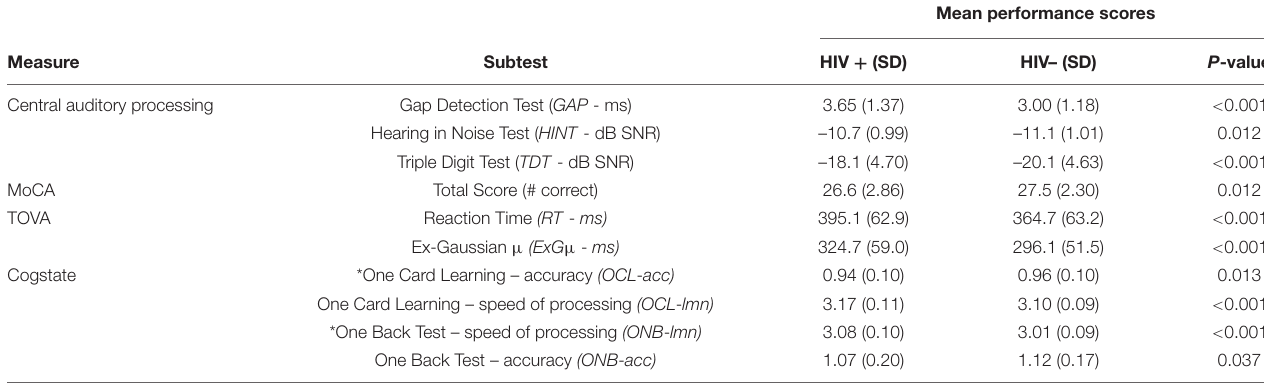
TABLE 3 | Mean central auditory and cognitive performance differences between HIV